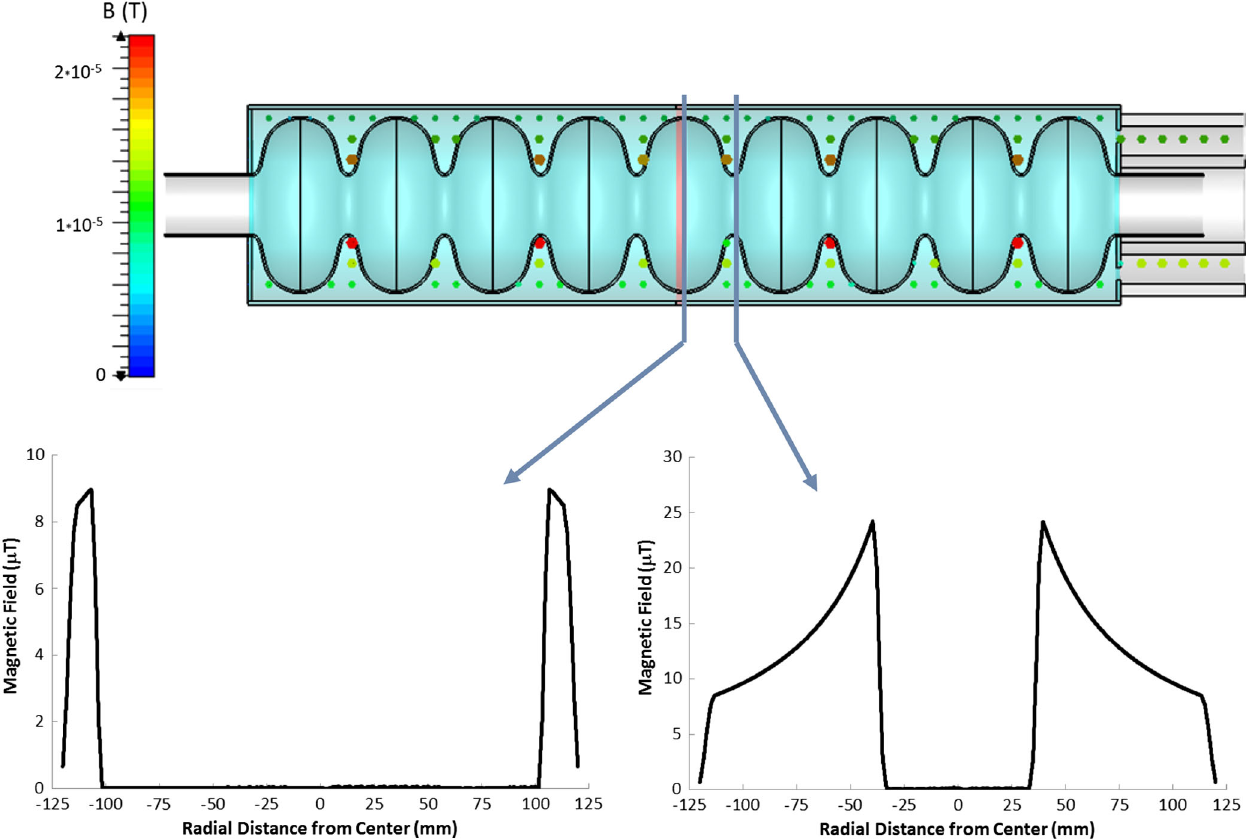
FIG. 13. Results of the numerical field simulation with the parameters given in the text, assuming azimuthal symmetry. The top graph shows the 3-D field configuration, plots below give z -axis-cuts along one equator (bottom left) and at an iris (bottom right), both locations where close to the cavity center. Positive radial distance is defined as above centerline. As expected, the magnetic field resulting from the thermocurrent fully vanish inside the